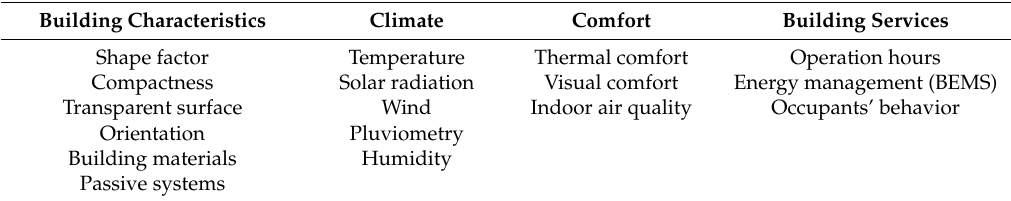
Table 3. Parameters that determine terminal building energy